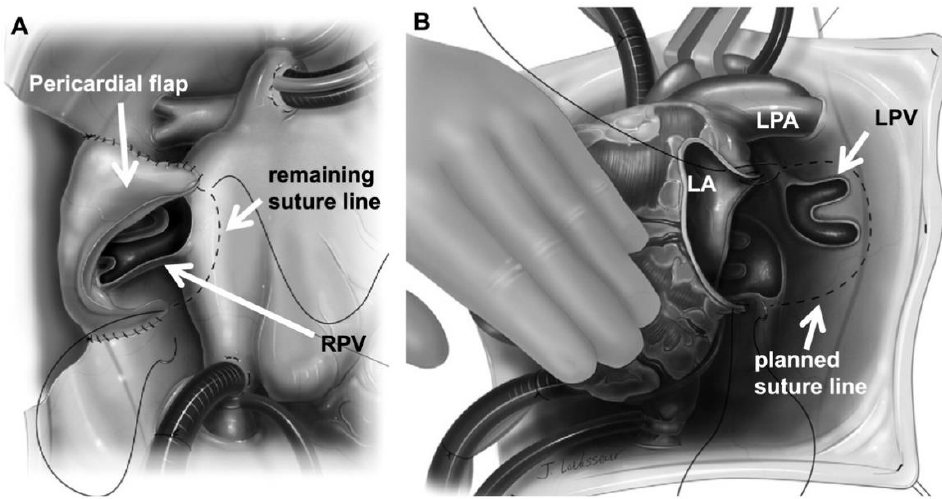
Figure 1. Sutureless repair. ( A ) Right pulmonary vein repair. Veins are opened widely and diseased tissue is resected. Pericardial flap is folded down and sewn to left atrium leaving cut edge of veins without sutures; ( B ) Left pulmonary vein repair. Heart is retracted rightward. Left pulmonary veins are widely opened and left atrial appendage is sewn to pericardium outside/around veins. (RPV = right pulmonary veins; LA = left atrium; LPV = left pulmonary veins; LPA = left pulmonary artery; Dashed lines = planned suture line for left atrial-pericardial anastomosis). Adapted from Viola, N.; Calderone, C.A. Surgical repair of post- repair pulmonary vein stenosis using “sutureless” techniques. Op Tech Thorac Cardiovasc Surg 2011, 15, 112 – 121.